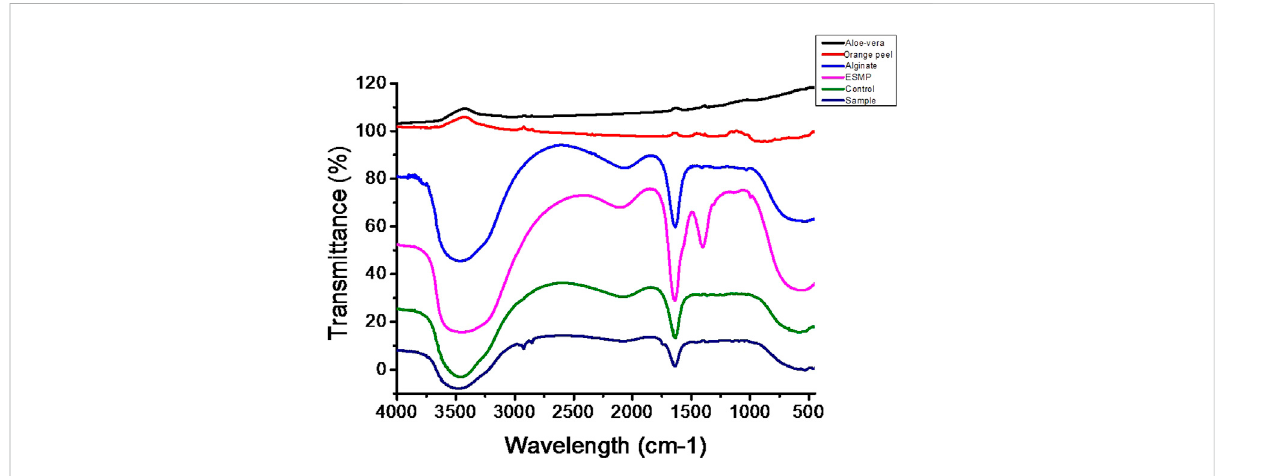
FIGURE 5 FTIR spectra of the bio-polymeric bead components, including those of control bio-polymeric beads (alginate, Aloe vera , orange peel), and ESMP-modi fi ed sample beads (alginate, Aloe vera , orange peel, ESMP).